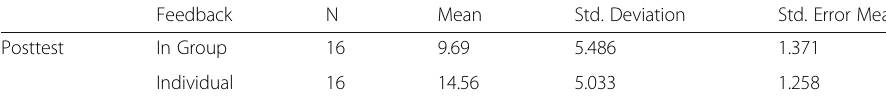
Table 10 Descriptive statistics; posttest of speech acts by groups Feedback N Mean Std.